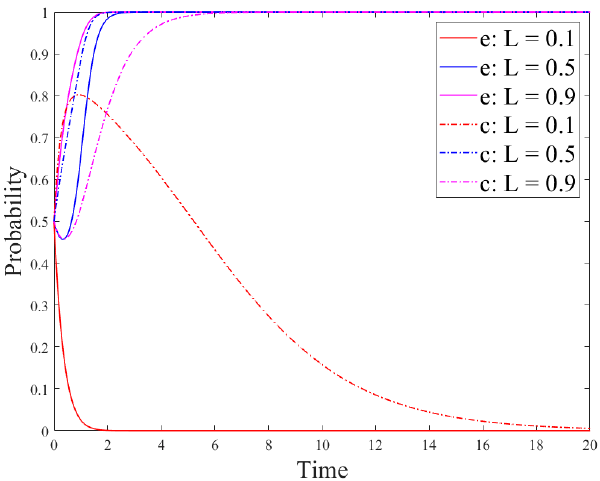
Figure 14. Evolution results of the enterprise and consumer strategies ( e : enterprise, c : consumer).